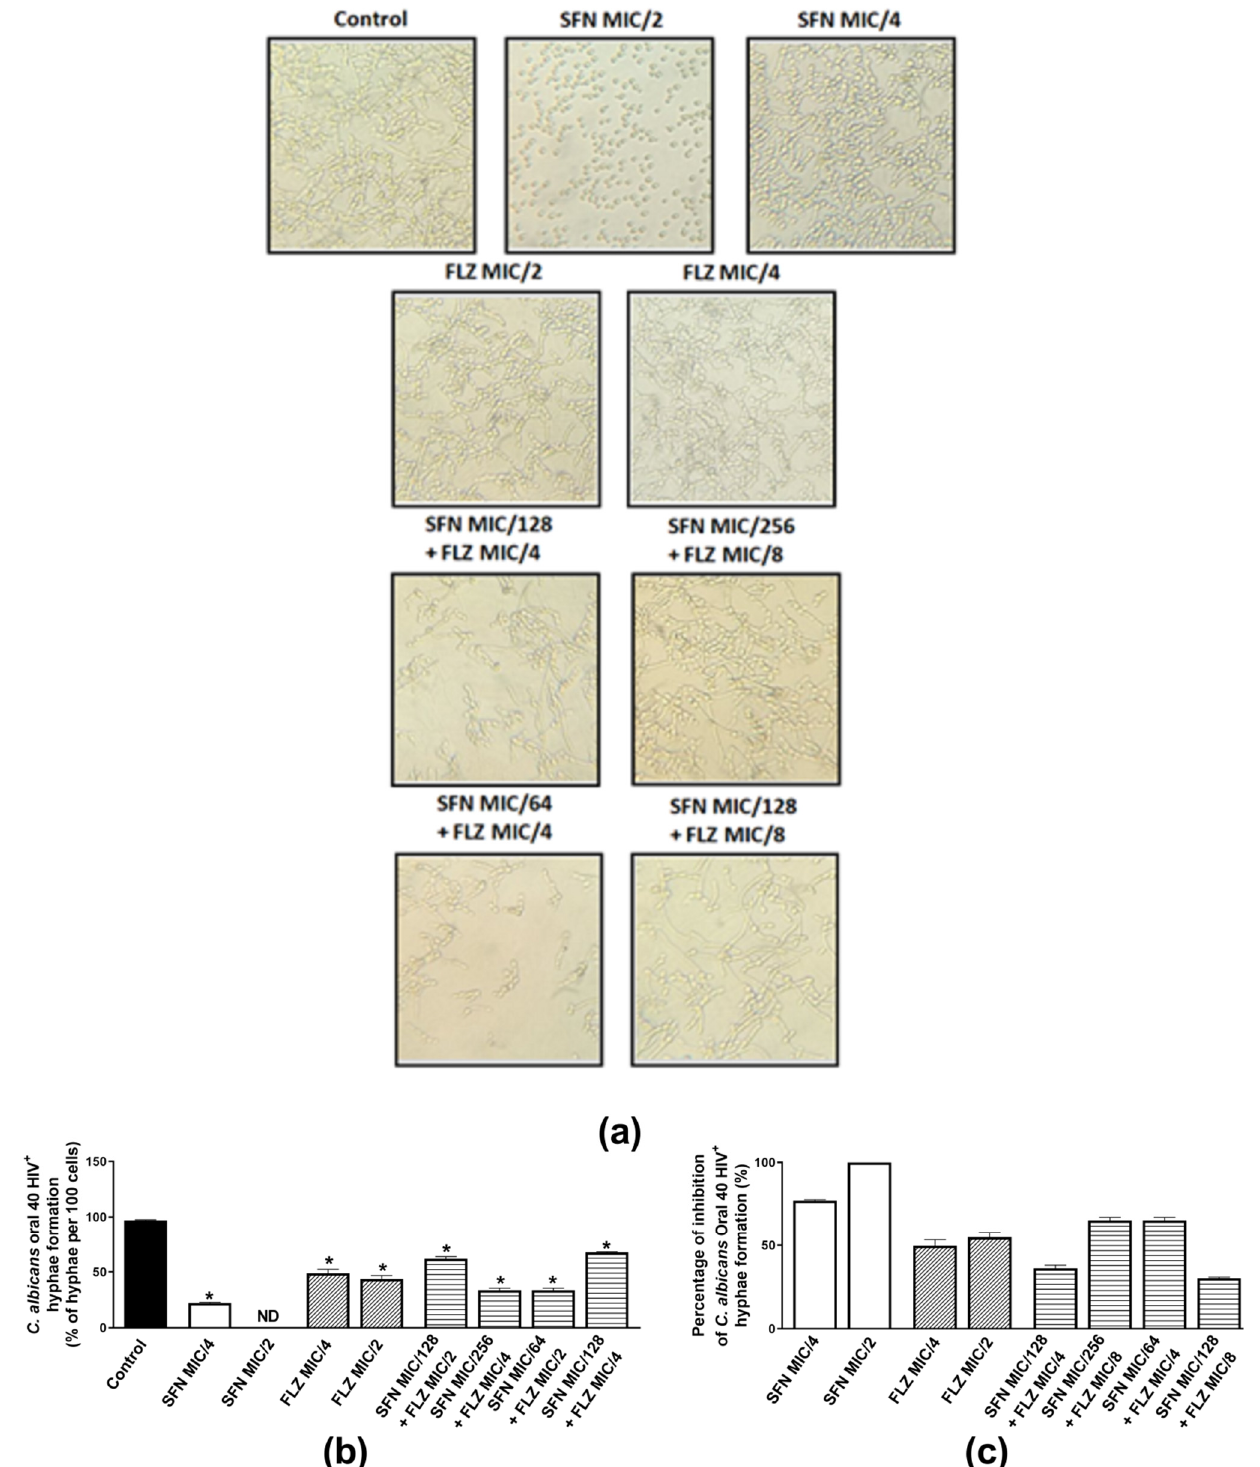
Figure 2. Effects of sulforaphane (SFN) and fluconazole (FLZ) on hyphae formation by C. albicans oral isolate 40 HIV + . ( a ) Representative images of hyphae growth by Oral 40 HIV + incubated with either FLZ or SFN at MIC/2 and MIC/4. The same panel represents the combined effects of SFN (MIC/64 to MIC/256) and FLZ (MIC/4 and MIC/8). ( b ) Percentage of hyphae per 100 cells of Oral 40 HIV + and ( c ) percentage (%) of inhibition of Oral 40 HIV + hyphae formation. The control consisted of inoculum plus phosphate-buffered saline (PBS) containing 10% fetal bovine serum (FBS). * p < 0.05 differs from the control